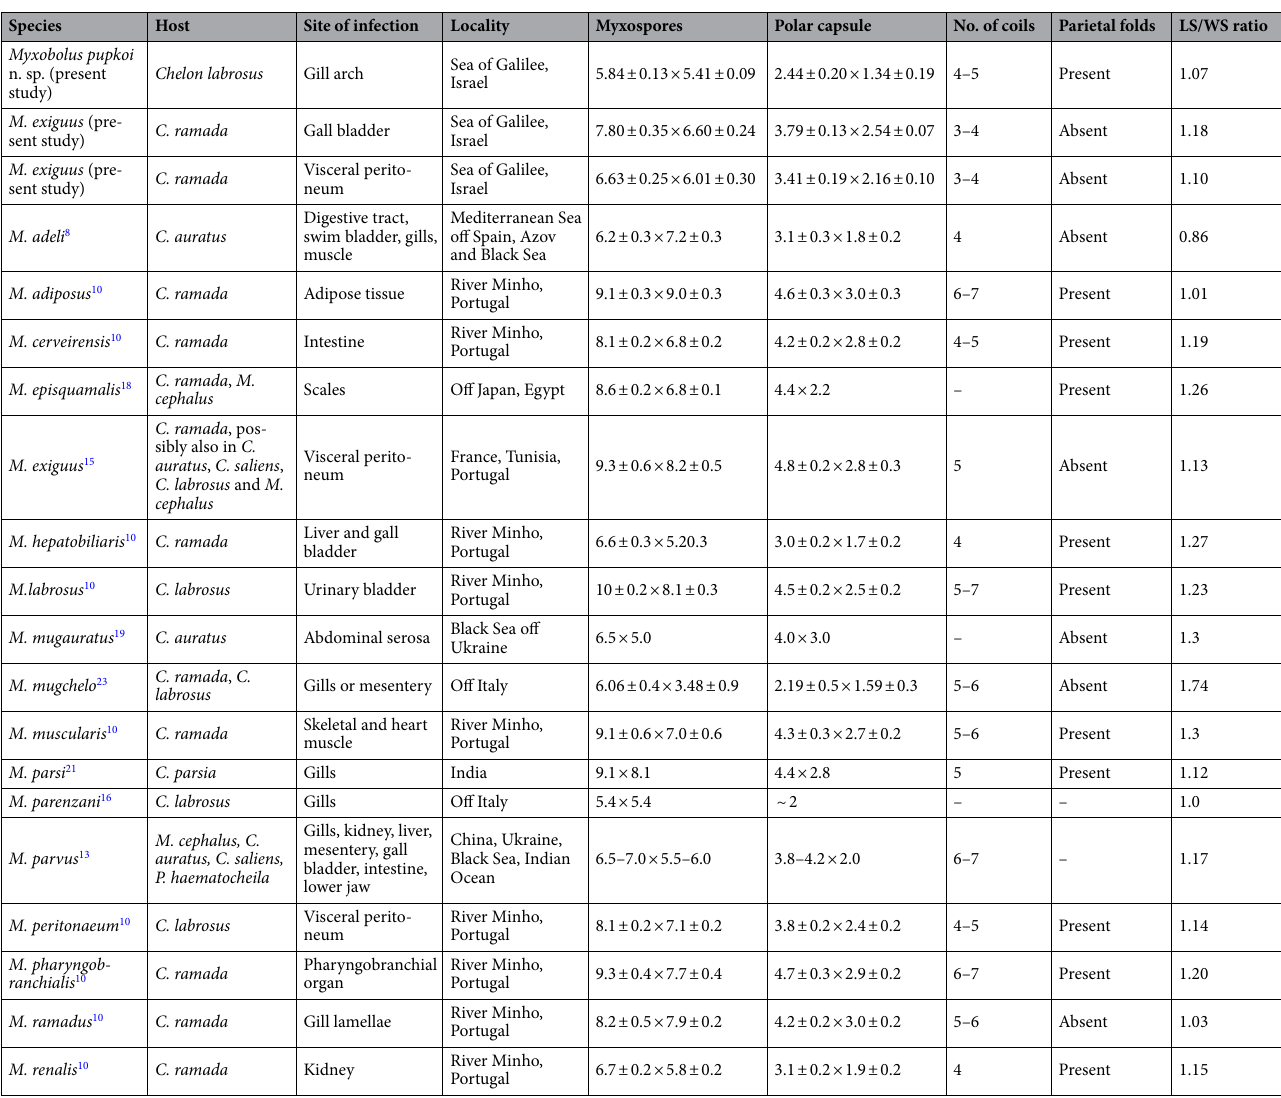
Table 2. Comparative description of Myxobolus pupkoi n. sp. with myxobolid species infecting the genus Chelon (measurements in